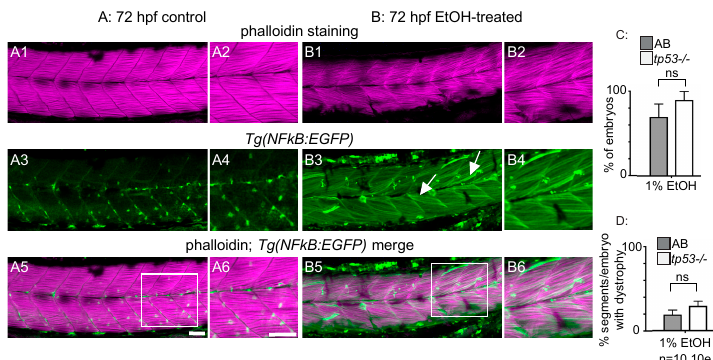
Figure 3. NF-kB-dependent inflammation is present, but p53-dependent apoptosis is not required for EtOH-induced fiber detachments. ( A1 – B6 ) Anterior left, dorsal top, side-mounted 72 hpf Tg(NF-kB:EGFP) embryos stained with phalloidin (pseudo-colored fuchsia) to visualize actin. ( A1 – 6 ) 72 hpf Tg(NF-kB:EGFP) control embryo. ( A1 – 2 ) Phalloidin channel only. ( A2 ) Zoomed-in view corresponds to white box in A5. ( A3 – 4 ) GFP channel only. ( A4 ) Zoomed-in panel corresponds to white box in A5. Note low NF-kB activity in muscle fibers. ( A5 ) Phalloidin and NF-kB-EGFP channels